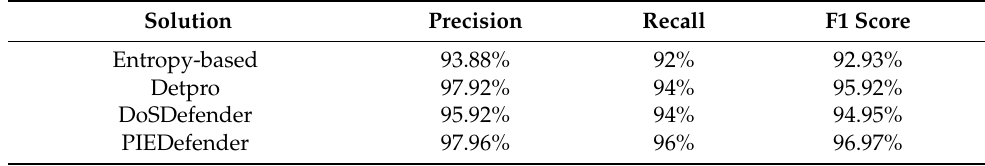
Table 3. Results of different detection